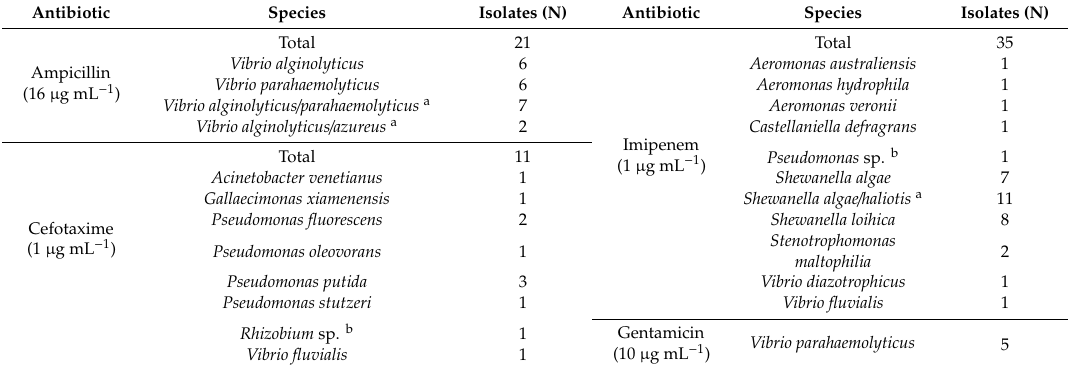
Table 2. Identity of bacterial species recovered from San Francisco Bay sediment, 2015, by antibiotic used to select for resistance in initial MacConkey agar plate.